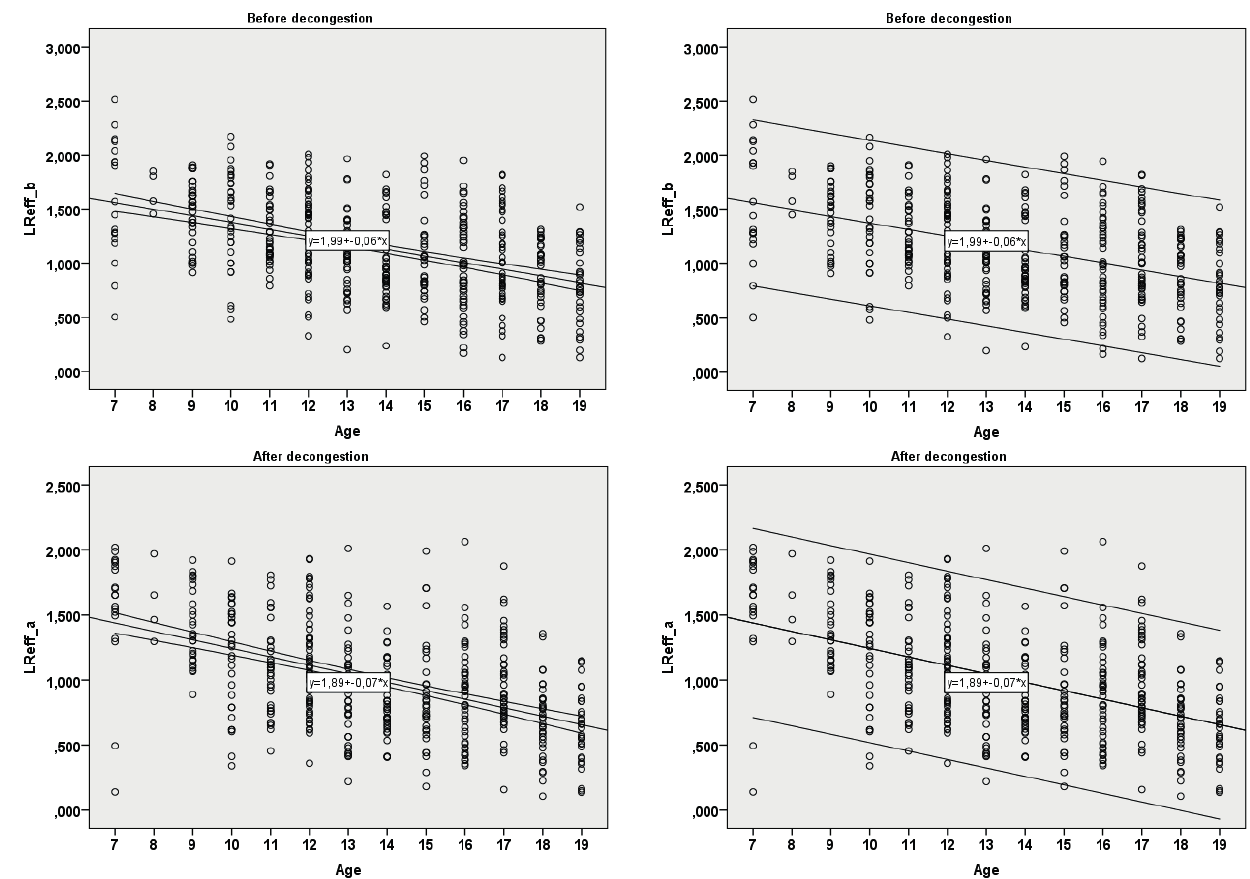
Figure 4. Dependency of logarithmic effective resistance on age before and after decongestion. The left side shows 95% confidence intervals for mean prediction, and the right side shows 95% confidence intervals for individual prediction. LReff, logarithmic effective